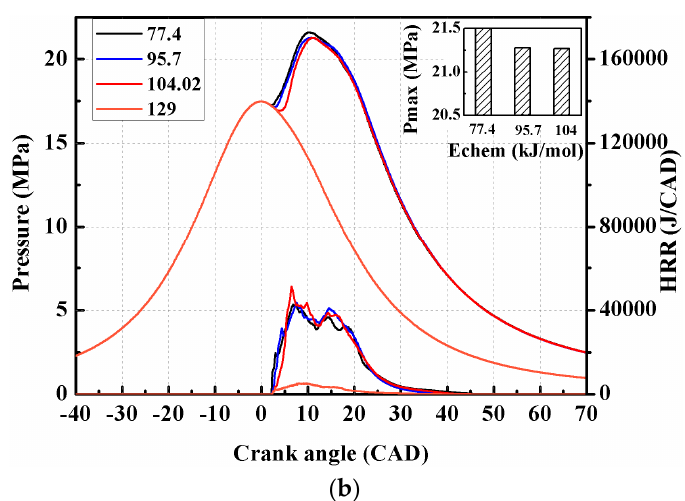
Figure 12. Combustion performance of marine engine fueled with diesel-like fuel at different engine speeds. ( a ) 169 rpm; ( b ) 676 rpm.